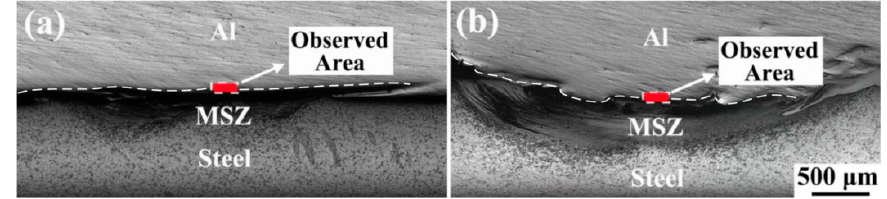
Figure 3. Macrographs of the FSLW joints ( a ) without a Ni interlayer and ( b ).with a Ni interlayer.